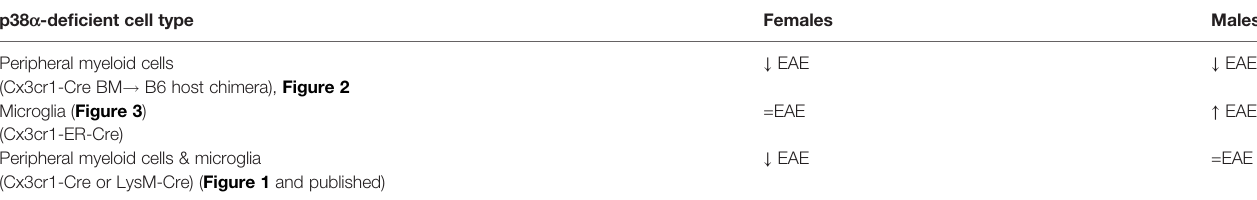
TABLE 2 | A model for cell speci fi c effects of p38 a deletion in microglia and/or peripheral myeloid cells. p38 a -de fi cient cell